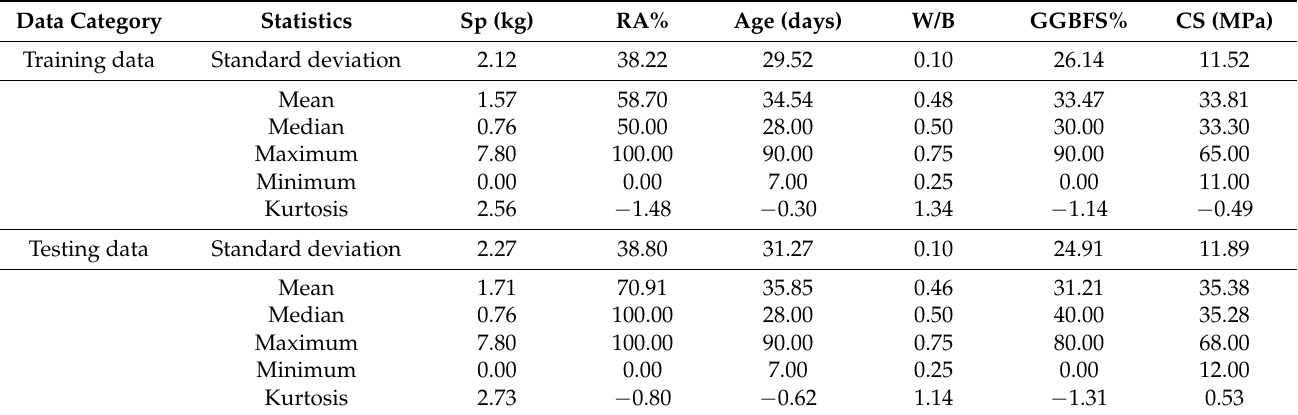
Table 2. Input and output key parameters for the